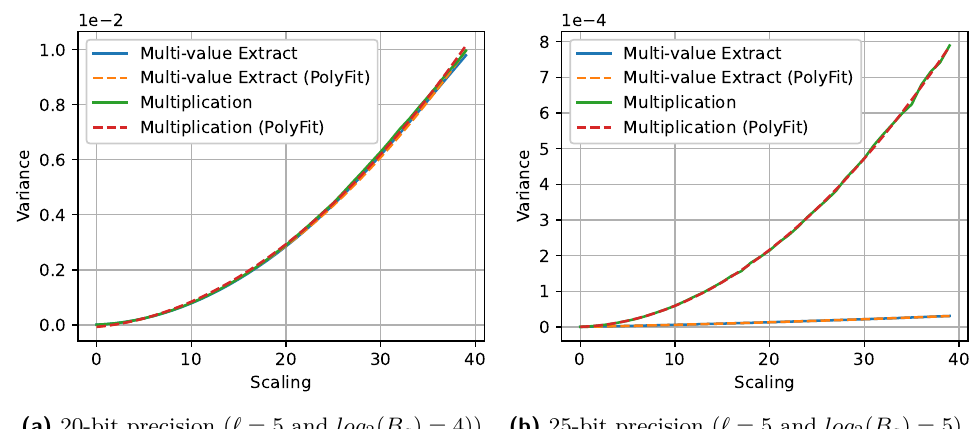
Figure 4: Comparison between the variance of scaling using the multi-value extract and direct multiplication.